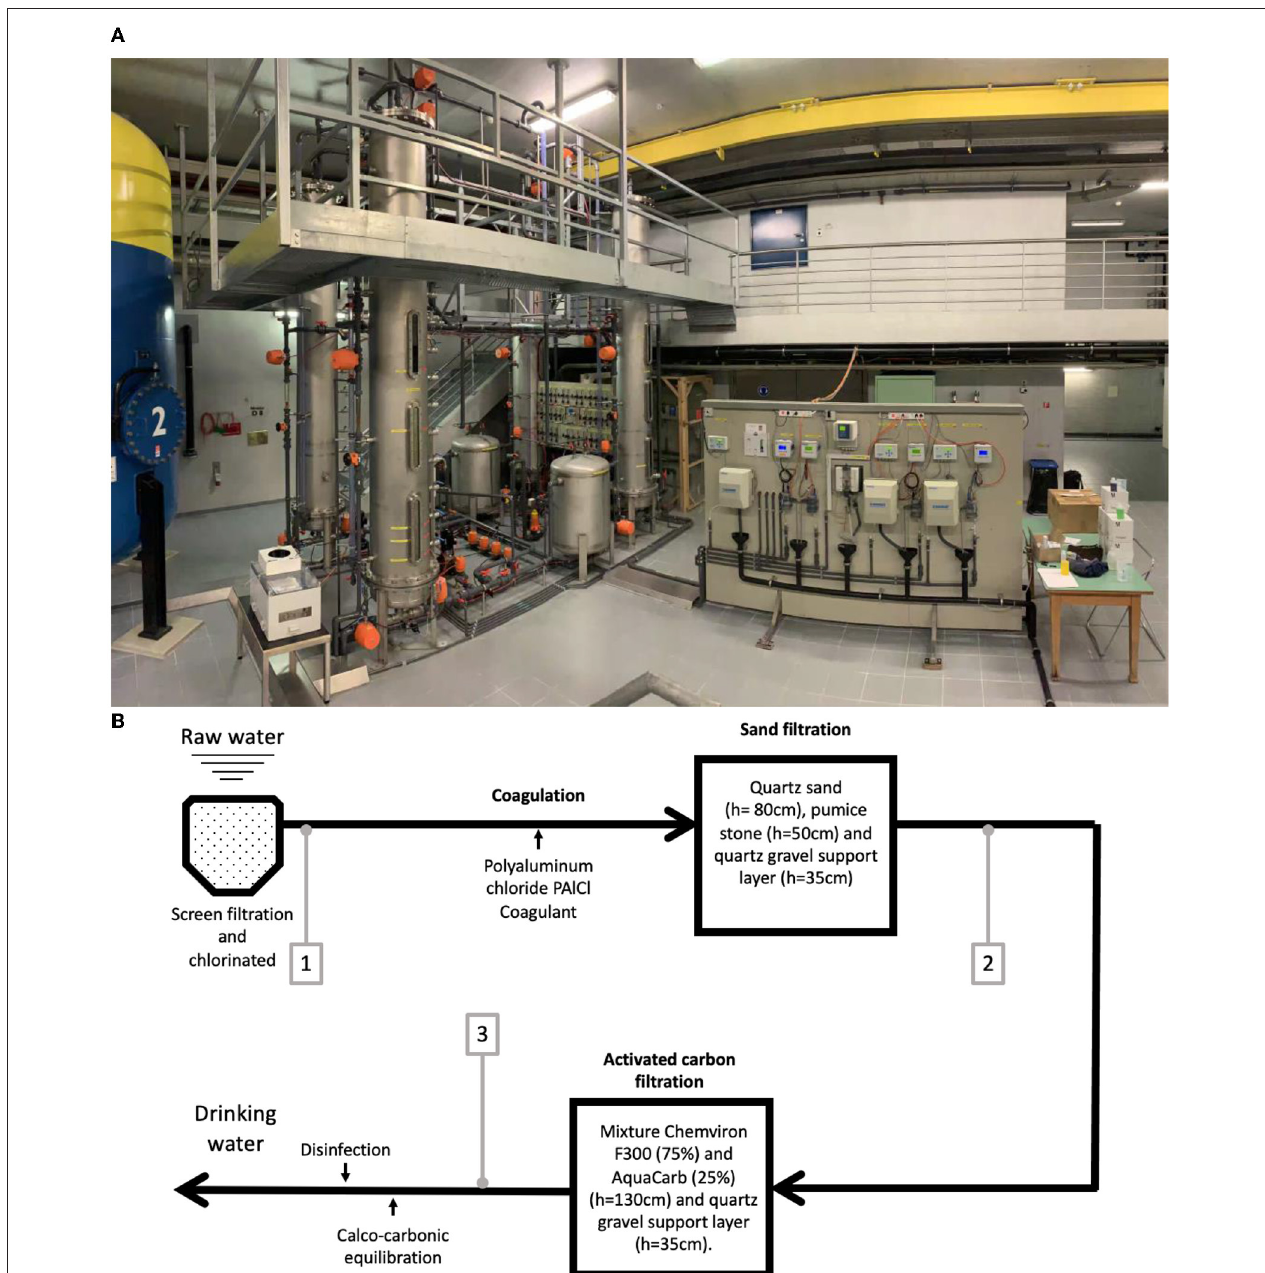
FIGURE 1 | Picture of the corresponding pilot station (1 m 3 /h) that replicates the main DWTP in Geneva (A) and scheme of the drinking water treatment with marked sampling sites (1/2/3) (B)